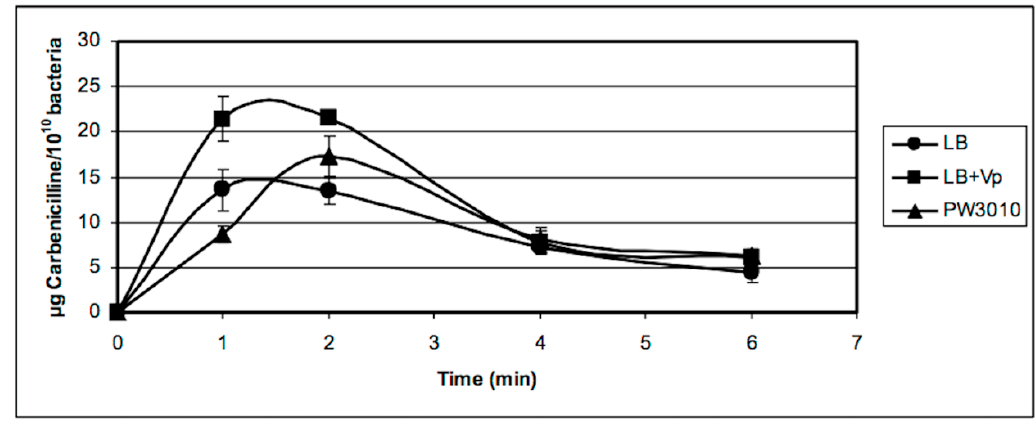
Figure 6. Kinetics of accumulation of carbenicillin in the periplasm of P. aeruginosa PAO1 and its mutant in the PA1113 gene (PW3010) in the presence (LB + Vp) or absence (LB and PW3010) of verapamil. P. aeruginosa PAO1 suspended in LB medium or LB + 1 × 10 − 7 M verapamil at a concentration of 1 × 10 10 bacteria per mL was incubated for 20 min at 37 °C before starting the kinetics. The kinetics and recovery of periplasmic contents were carried out as described in the Materials and Methods section. The amount of carbenicillin in periplasmic extracts was determined from a standard range established with the high sensitive bacterium Bacillus subtilis 168 and plotted against time. The results presented in the figure are the mean values of at least three independent experiments.